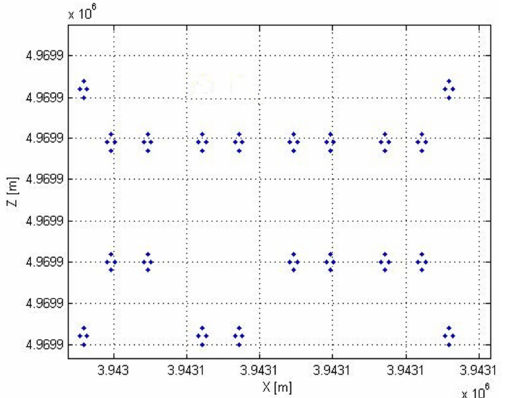
Figure 7. Example of increasing in the number of TPs for a corner of the module (4 points for each